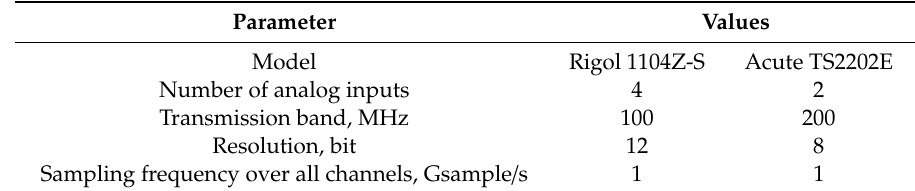
Table 5. Oscillograph